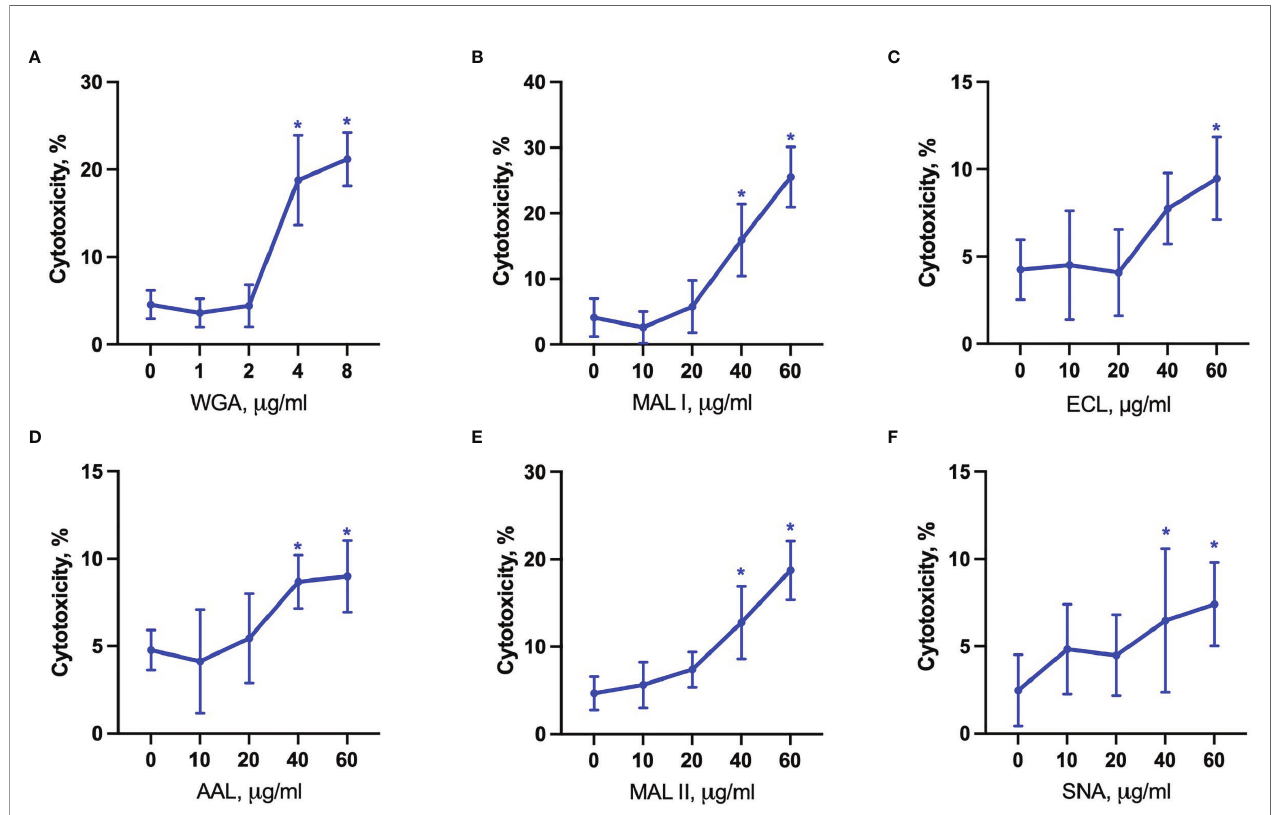
FIGURE 7 | Lectin-induced cell death in YAMC cells. Cytotoxicity was measured by propidium iodide and Hoechst 33342 staining of cells after treatment with WGA (A) , MAL I (B) , ECL (C) , AAL (D) , MAL II (E) , SNA (F) lectins in YAMC for 20 h at 33°C. Data represent averages and SD of 6 replicates out of 2 independent experiments. *p < 0.05; one-way ANOVA followed by Bonferroni ’ s multiple comparison